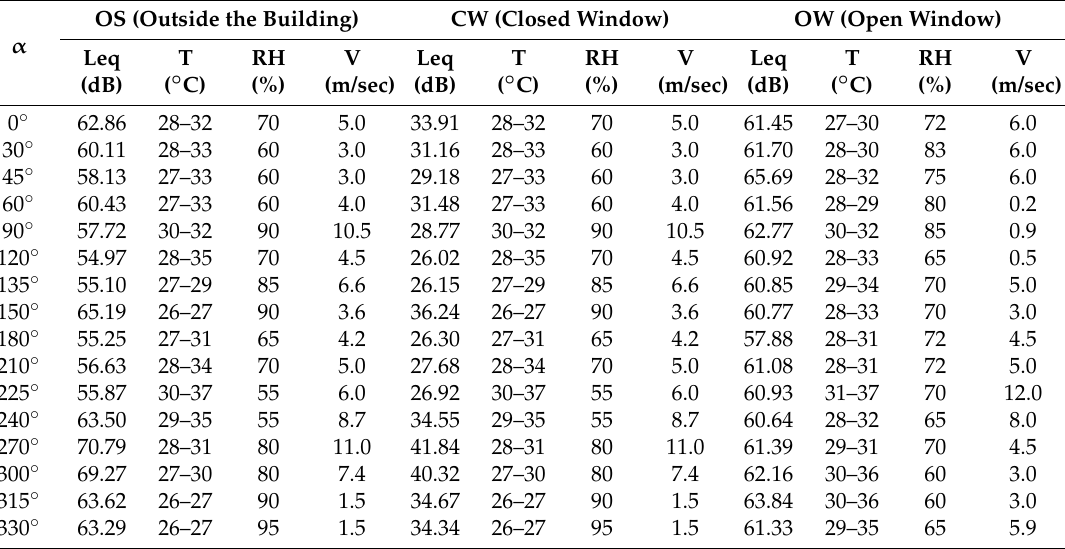
Table 7. Summary of average sound pressure level at